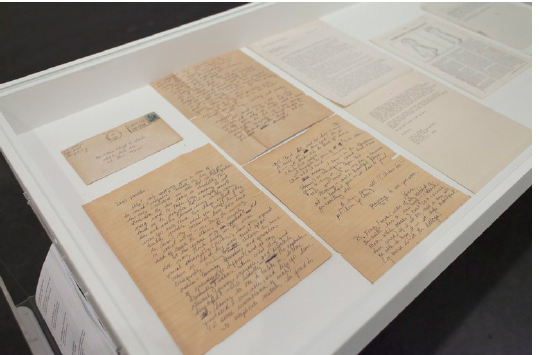
Figure 2. Brooklyn Museum. Digital Collection and Services. We Wanted a Revolution: Black Radical Women , 1965-85. [04/21/2017-09/17/2017]. Installation